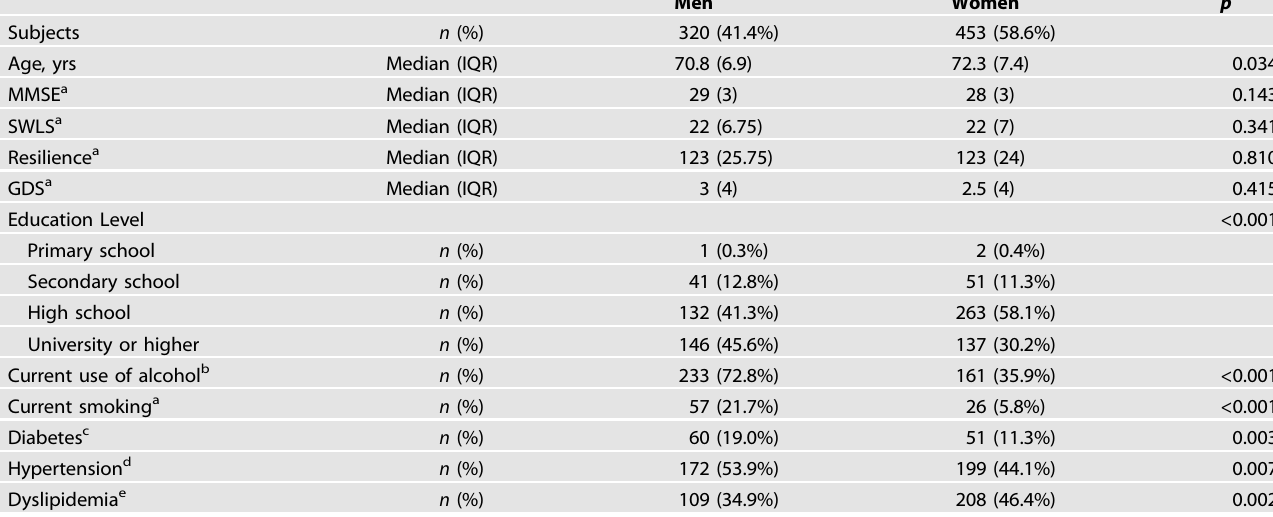
Table 1. Demographic data of the participants from the Arakawa 65 + Study, Tokyo, Japan ( n = 773,